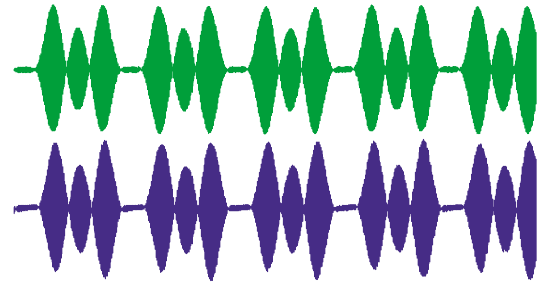
Fig. 8. Measured and curve-fitted (shifted by a constant) response